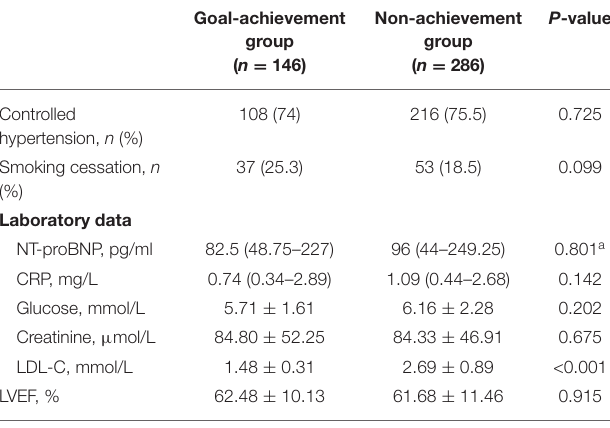
TABLE 2 | One-year follow-up characteristics.